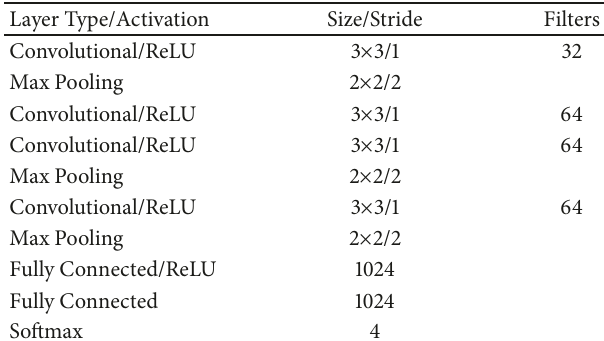
Table 1: The structure of C4M3F2.